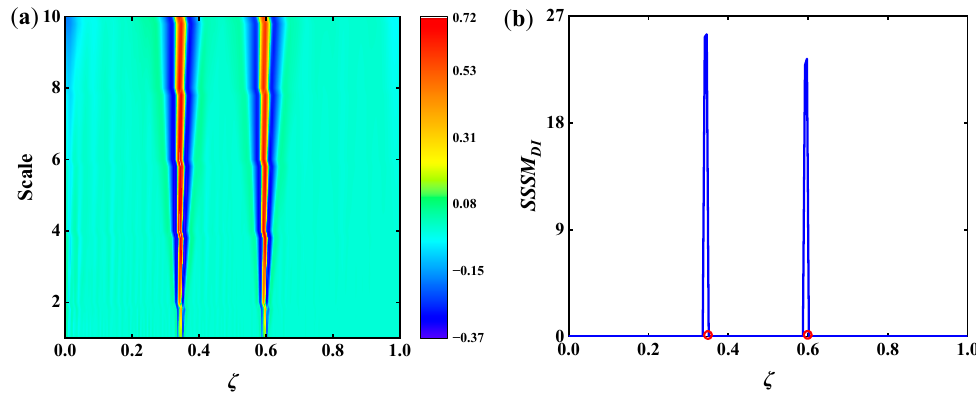
Figure 19. Identification results of cracked cantilever beam under scenario II when γ = 5%: ( a ) CS ( b, s ) ; ( b ) Damage index SSSM DI